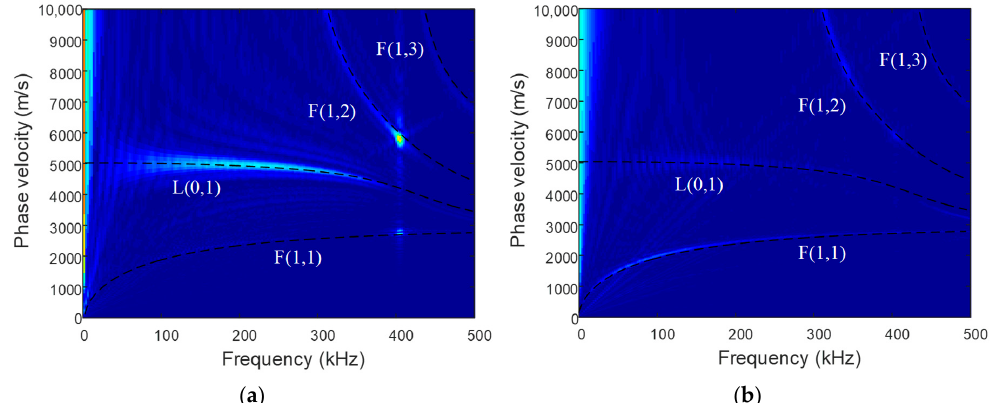
Figure 9. The phase velocity dispersion spectra of two wires from nodal accelerations with an equal components triangular pulse force along the x , y , and z directions: ( a ) the active wire and ( b ) the passive wire. The theoretical phase velocity dispersion curves obtained in Figure 1a are represented by the black dotted lines.